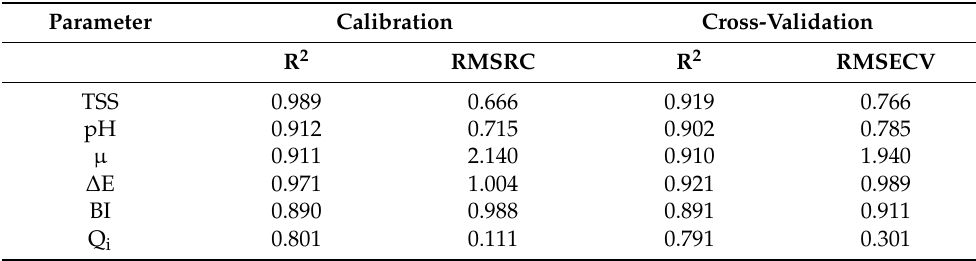
Table 4. PLSR performance for TSS, pH, µ , ∆ E, BI, and Q I of flavored laban drinks for both calibration and cross-validation